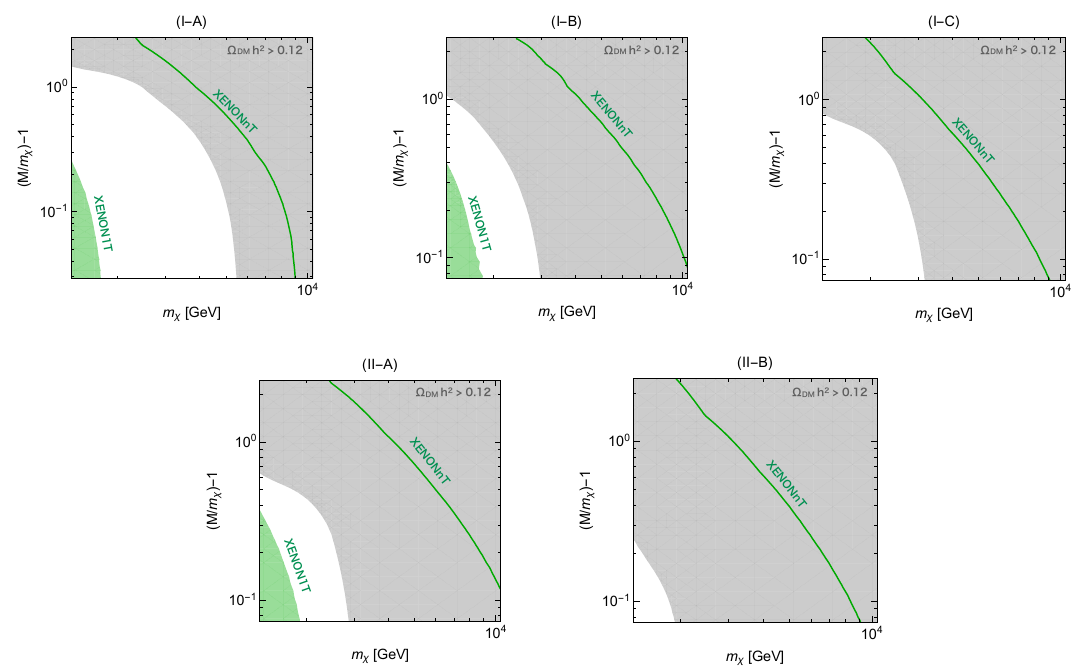
Figure 13 . Current limits provided by XENON1T [80] (green shaded area) and expected sensitivity of XENONnT [81] (green solid line) in the parameter space of each model. The gray shaded area represents the region where the DM density exceeds the observed value: (cid:10) DM h 2 take arg( b ) =